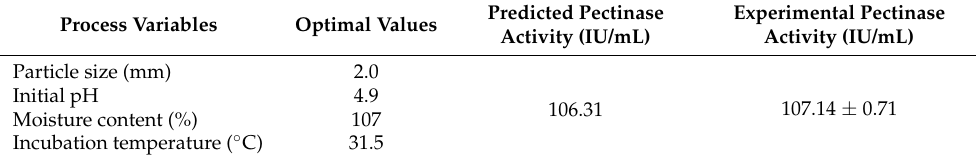
Table 4. Process variables optimal values for maximum pectinase